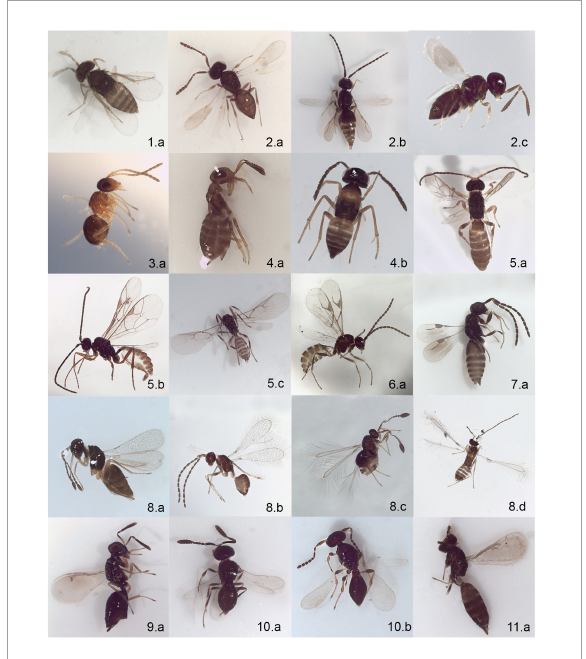
FIGURE2 Morphotype catalog of parasitoid wasp (Hymenoptera) diversity as collected from pitfall traps on four green roofs across the urban core of Portland,